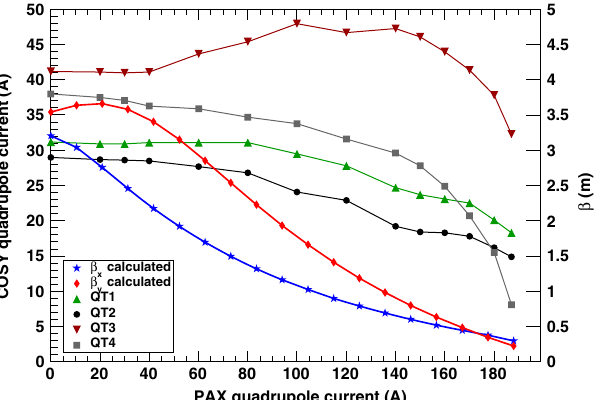
FIG. 14. Currents in the COSY quadrupoles and the betatron amplitudes vs current of the PAX low- β quadrupoles. With increasing strength of the low- β magnets, the betatron amplitudes β (in blue) and β (in red)(right scale) decrease. The currents in x y the COSY quadrupoles (QT1-QT4) were reduced to keep the tune constant, using a D ≠ 0